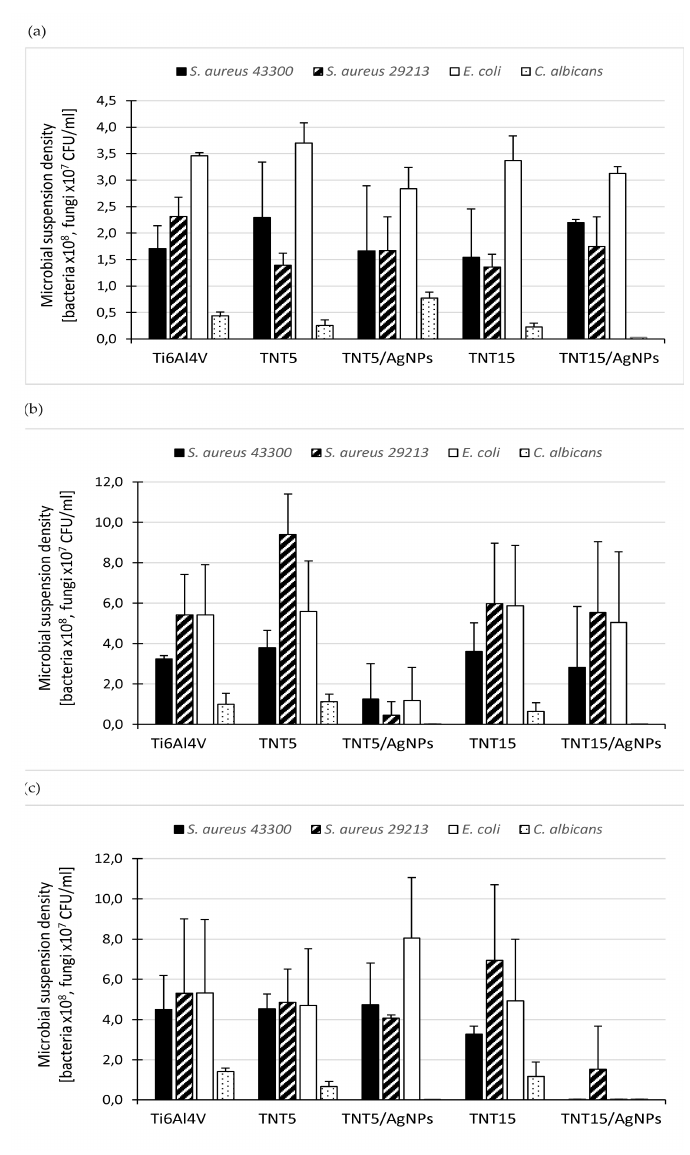
Figure 9. Antimicrobial e ff ect of the supernatants obtained after 24 h ( a ), 2 weeks ( b ), and 4 weeks of ( c ) TNT- and TNT / AgNPs-modified Ti6Al4V surfaces’ incubation in PBS, tested using the culture method and colony forming unit (CFU) counting. The results are presented as the mean microbial suspension density [CFU / mL] ± standard deviation (SD) after 24 h of culture in the presence of the tested